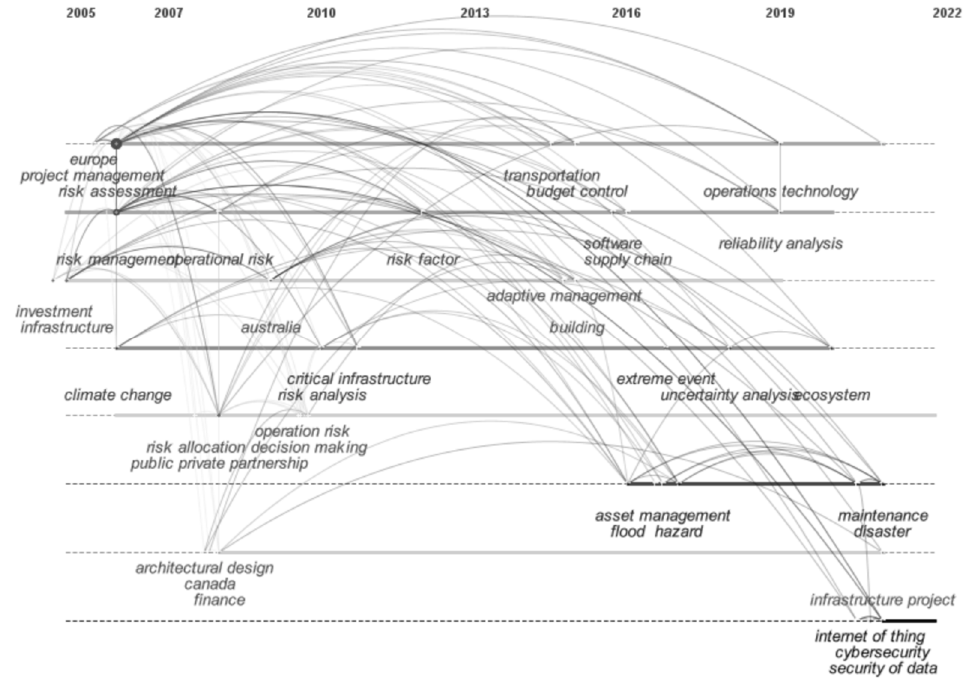
Figure 3. Main research areas in operational risk of infrastructure projects (co-occurrence network